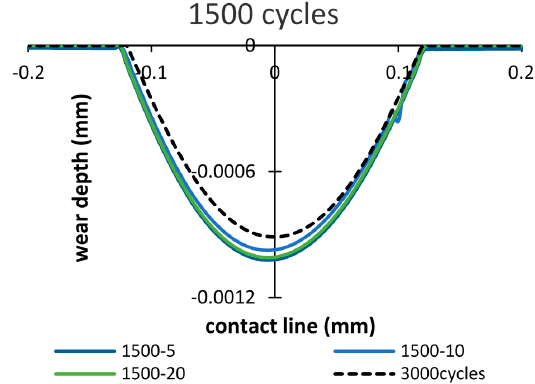
Figure 13. Wear scar after 3000 cycles of the debris layer model: importing time = 500 cycles and layer thickness = 5 µm, 10 µm, 20 µm.